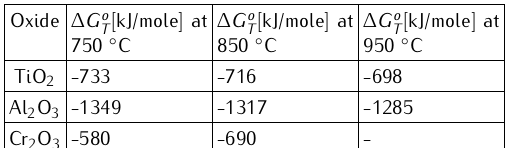
Table 1. ∆ G o T free energies in kJ/mole of formation of oxides at tem- perature range 750 - 950 ◦ C